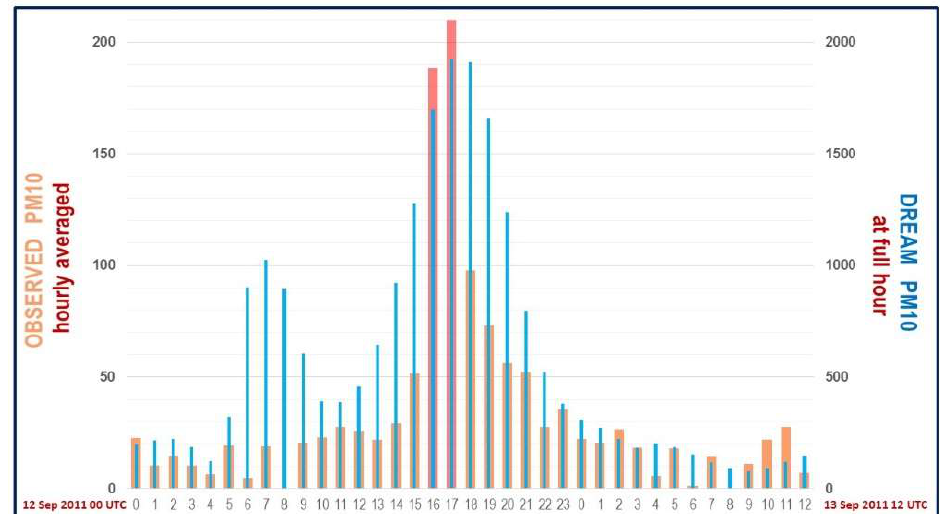
Figure 8. Reykjavik dust storm evidence, time period 12 September 2011 00UTC–13 September 2011 12UTC; orange and red bars: Hourly averaged observed PM 10 concentration (µgm −3 ); blue bars: pre- dicted surface PM 10 dust concentration (µgm −3 ).